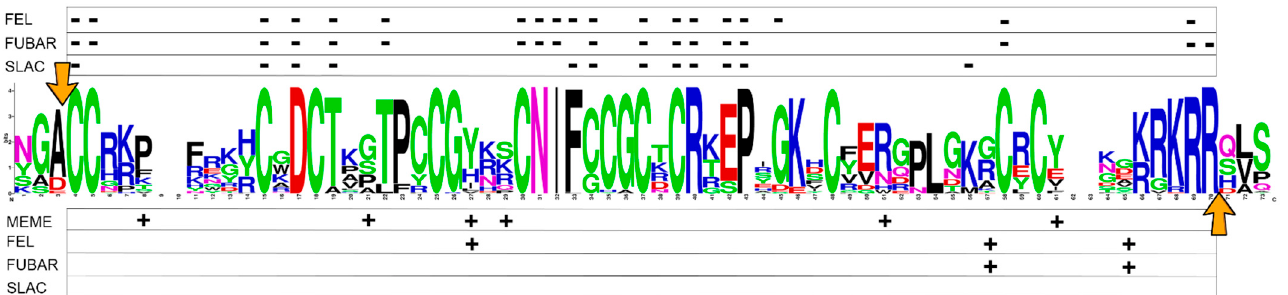
Figure 5. Positive and negative selection analysis. The mature peptide of the mytimycins with an uninterrupted CDS were selected to perform the analysis. Four prediction models have been used (MEME, FEL, FUBAR, and SLAC). Positive selection sites and negative selection sites are collected on the graph, using +/ − symbols respectively. Orange arrows point to the beginning and end site of the mature peptide, marking the signal peptide and propeptide cleavage sites, respectively.